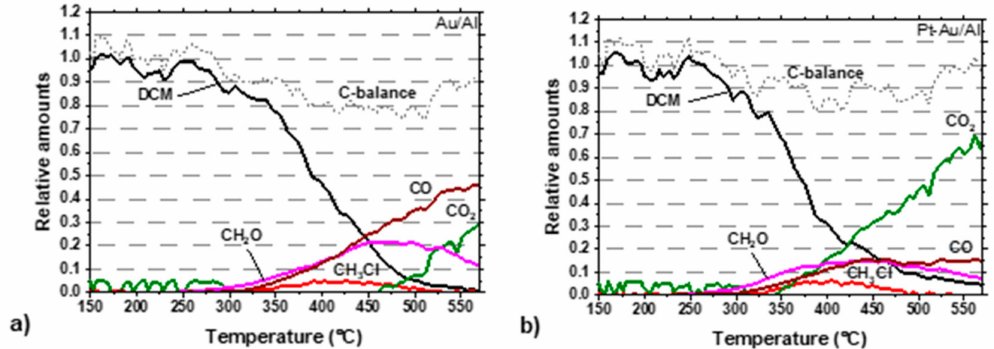
Figure 8. DCM oxidation over ( a ) Au / Al and ( b ) Pt-Au / Al catalysts (the same conditions as in Figure